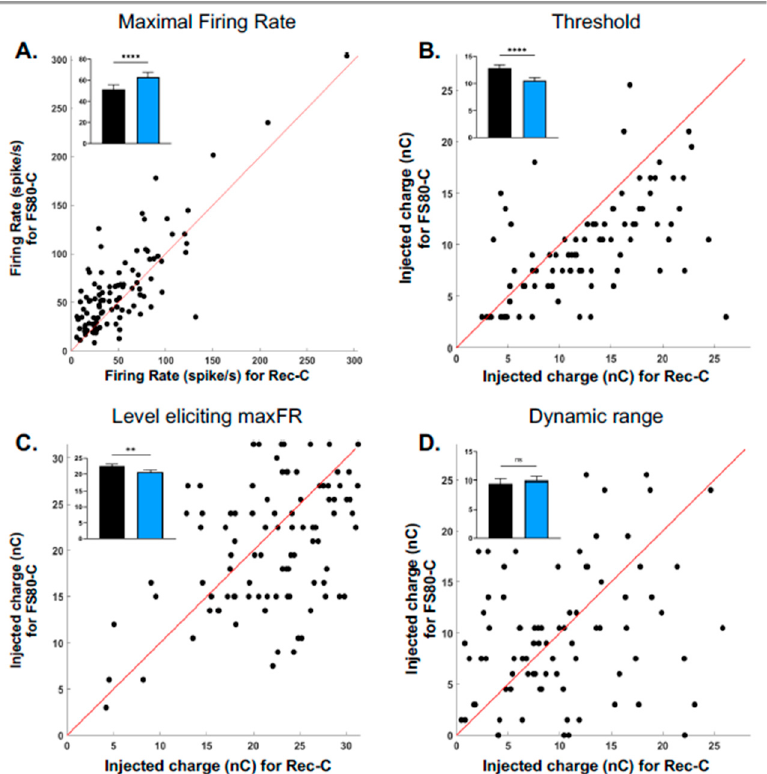
Figure 3. Scattergrams comparing the values obtained with ramped pulses (Fixed Slope of 80°) with those obtained with rectangular pulses on four parameters of evoked responses. For all scattergrams, each dot represents a single recording, and the red diagonal line is the equality line. ( A ) Maximal evoked firing rate (MaxFR) for the rectangular pulses vs. MaxFR for the ramped pulses. For a large number of recordings (86/106 dots above the diagonal line) the Max FR elicited by ramped pulses was higher than by the rectangular pulses. ( B ) Threshold for the rectangular pulses vs. threshold for the ramped pulses. For a large number of recordings (96/106 dots below the diagonal line) the threshold was lower with ramped pulses than with rectangular pulses. ( C ) Level eliciting the MaxFR for the rectangular pulses vs. for the ramped pulses. For a large number of recordings (76/106 dots below the diagonal line), this charge level was lower with ramped pulses than with rectangular pulses. ( D ) Dynamic Range for the rectangular pulses vs. for the ramped pulses. There was a similar number of recordings with a higher and a lower dynamic range with the ramped pulses. In each scattergram, the inset provides the mean values ± sem (** p < 0.01; **** p < 0.001; ns: not significant). Data are from 106 recordings obtained in 16 animals.